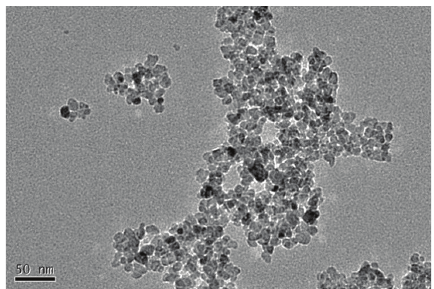
Figure 2: TEM micrograph of N-doped TiO 2